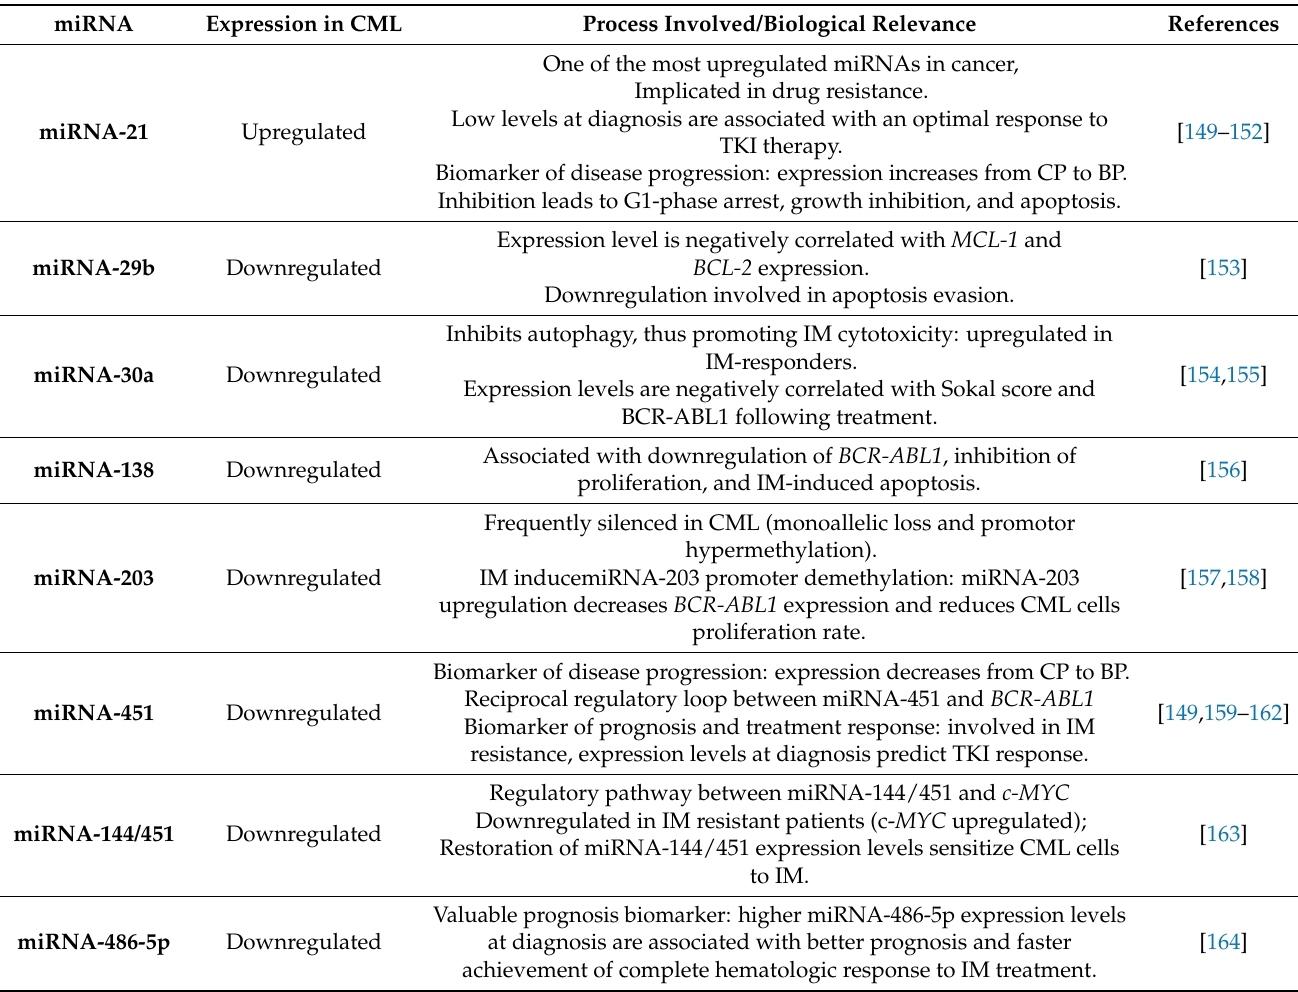
Table 2. miRNAs involved in CML